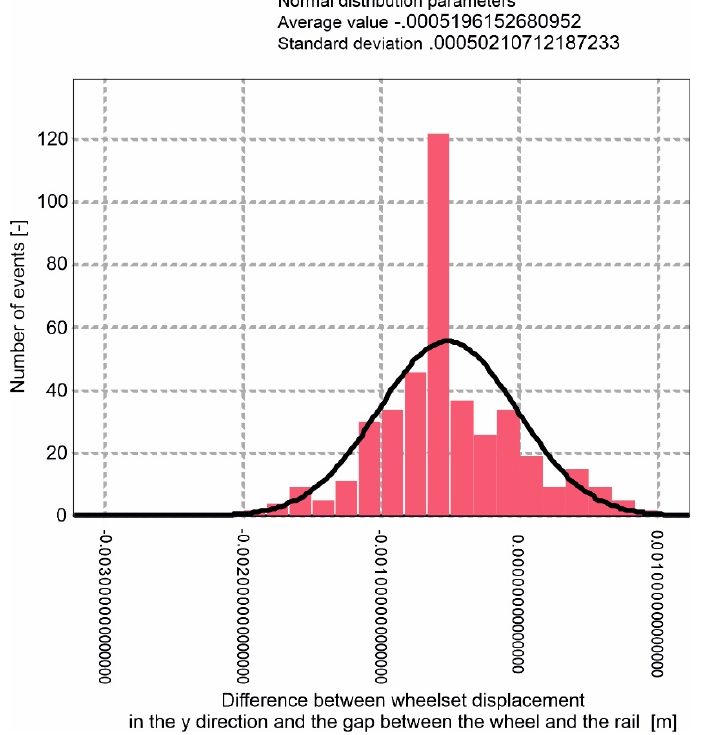
Figure 15. Normal distribution for the difference between displacement and a gap for a train crossing the turnout along a straight track at a speed of v = 200 km/h.